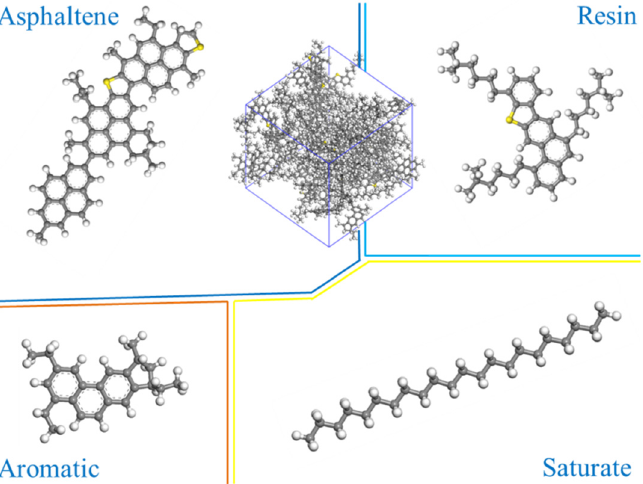
Figure 1. Molecular structure models of four asphalt components and matrix asphalt (carbon atoms are gray, sulfur atoms are yellow, and hydrogen atoms are white).